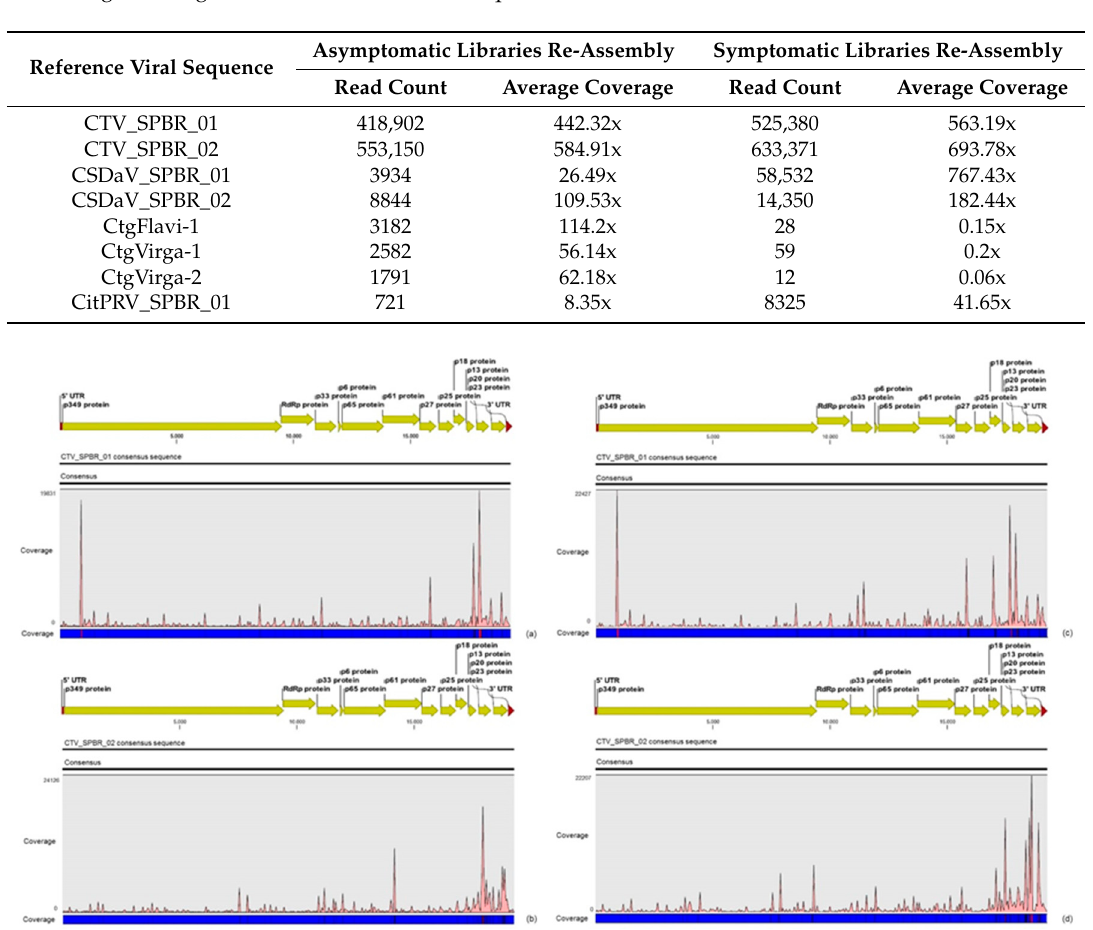
Figure 8. Profile distribution of reads from combined asymptomatic ( a , b ) and symptomatic ( c , d ) libraries along the two CTV consensus sequence obtained in this study: CTV_SPBR_01 ( a , b ); and CTV_SPBR_02 ( b , d ). Genome organization of the CTV references is shown above the respective graphic. Color scale varies from 0 (light blue color) to 100% of coverage (red color).